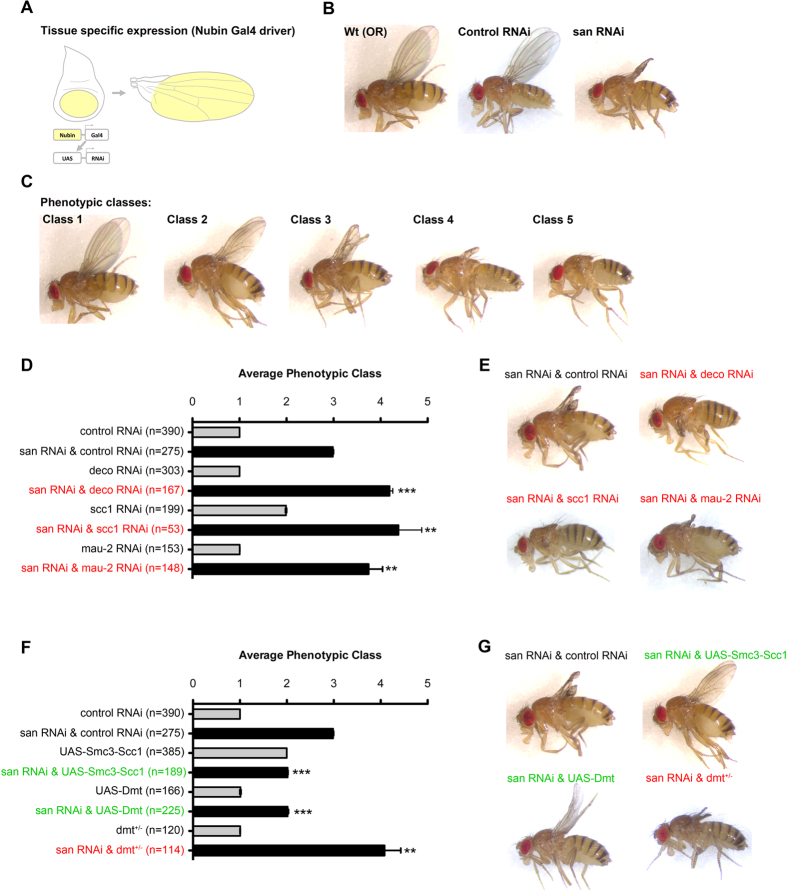
Naa50/San is required for the correct interaction between Scc1 and Smc3.(A) Wing blade-specific RNAi using the Nubbin-Gal4 driver4344 and the UAS/Gal4 system42. (B) Adult wings of wild type Drosophila (Oregon R; OR), Drosophila expressing a control RNAi (mCherry RNAi), and Drosophila expressing RNAi for san in the larvae wing imaginal discs. (C) Scored adult wing phenotypic classes: class 1 (wild type wings); class 2 (weak wing phenotype); class 3 (san RNAi-like wing phenotype); class 4 (highly abnormal wings); class 5 (absence/vestigial adult wings). (D) Quantification of Drosophila wing phenotypes expressing individual RNAi transgenes for mCherry, deco, scc1 or mau-2 (grey bars) or co-expressing san RNAi with mCherry RNAi, deco RNAi, scc1 RNAi, or mau-2 RNAi (black bars) in the larvae wing imaginal discs. (E) Representative adult wing phenotype of Drosophila co-expressing san RNAi with mCherry RNAi, deco RNAi, scc1 RNAi or mau-2 RNAi in the larvae wing imaginal discs. (F) Quantification of Drosophila wing phenotypes expressing a RNAi transgene for mCherry, a Smc3-Scc1 fusion construct58 or overexpressing Dmt in the larva wing imaginal discs, and Drosophila without one copy of Dmt (dmt+/−) (grey bars). Quantification of Drosophila wing phenotypes co-expressing san RNAi with mCherry, a Smc3-Scc1 fusion construct or Dmt in the larvae wing imaginal discs, and Drosophila without one copy of Dmt (dmt+/−) expressing san RNAi in the larvae wing imaginal discs (black bars). (G) Representative adult wing phenotype of Drosophila co-expressing san RNAi with mCherry RNAi, a Smc3-Scc1 fusion construct or Dmt in the larvae wing imaginal discs, and Drosophila without one copy of Dmt (dmt+/−) expressing san RNAi in the larvae wing imaginal discs. Phenotypic quantification of adult wings is mean ± S.D. of three independent experiments and is based on the classes described in (C) and Supplementary Fig. 1 (**p < 0.01 and ***p < 0.001, Student’s t test; n represents the total number of flies evaluated). The genotypes are written in green, black, or red if there was, respectively, suppression, no alteration, or enhancement of the original san RNAi wing phenotype. Detailed genotypes are indicated in Supplementary Table 1. Top left panels in (E) and (G), and wild-type panel in (B) and Class1 panel in (C), are the same.